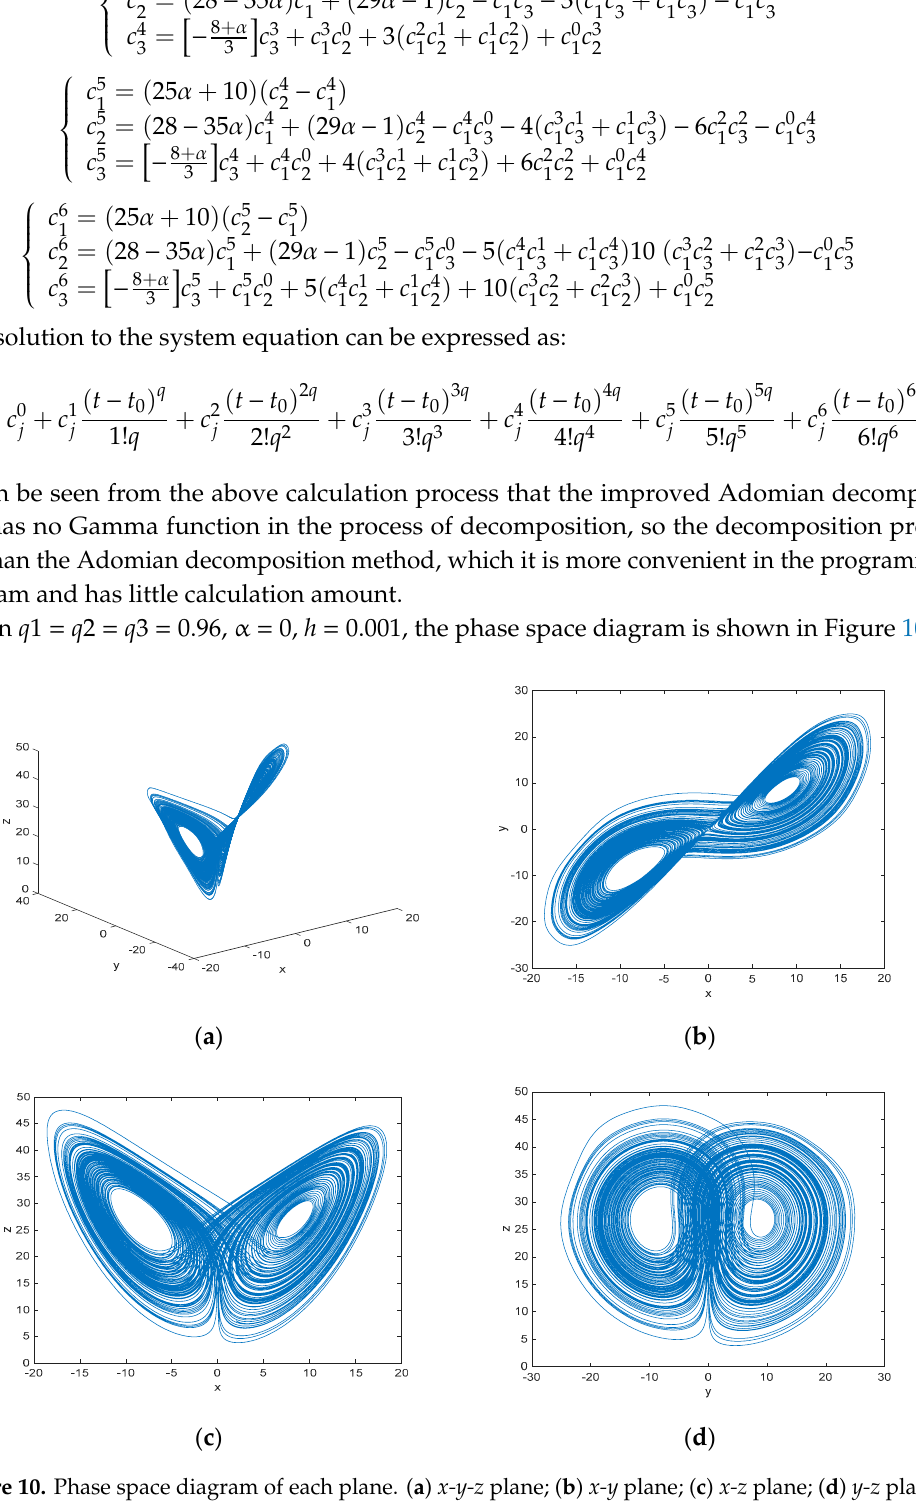
Figure 10. Phase space diagram of each plane. ( a ) x-y-z plane; ( b ) x-y plane; ( c ) x-z plane; ( d ) y-z plane.